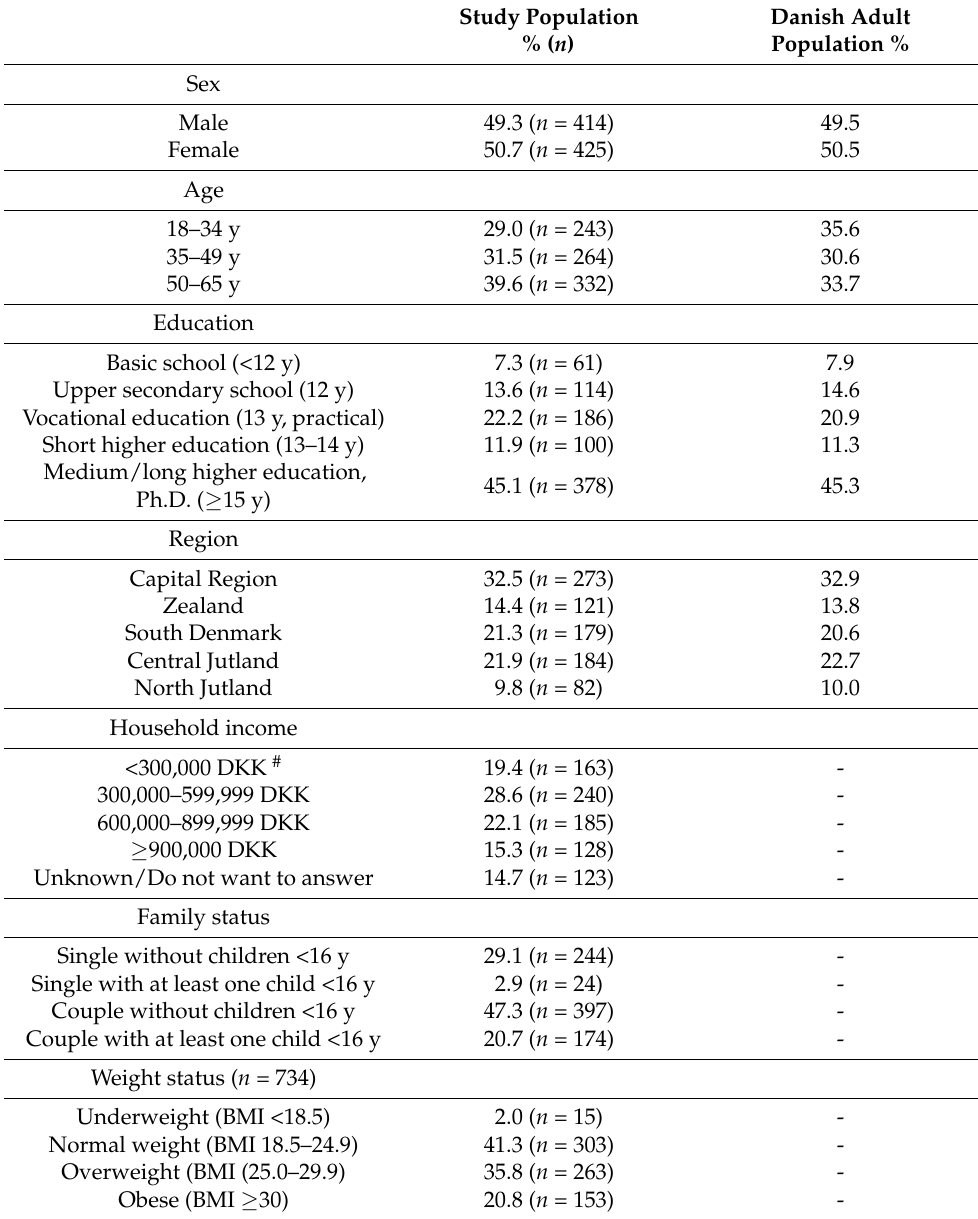
Table 1. Sociodemographic characteristics and weight status of the study population ( n = 839) and the Danish adult population (18–65